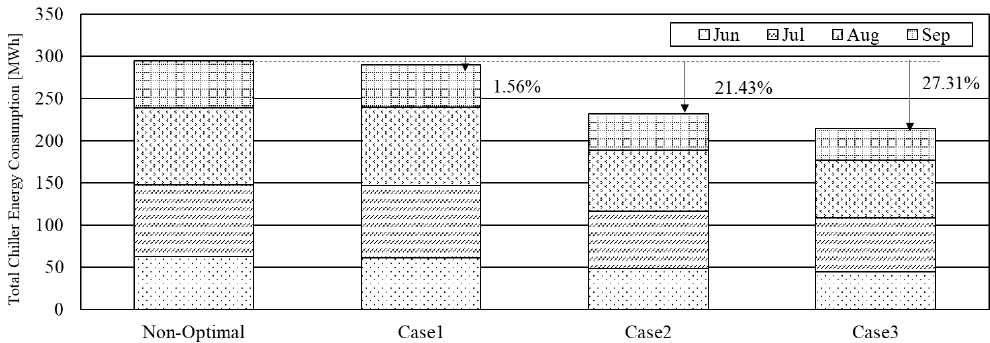
Figure 11. Comparison of chiller energy consumption between normal operation mode and optimal operation modes for June through September.